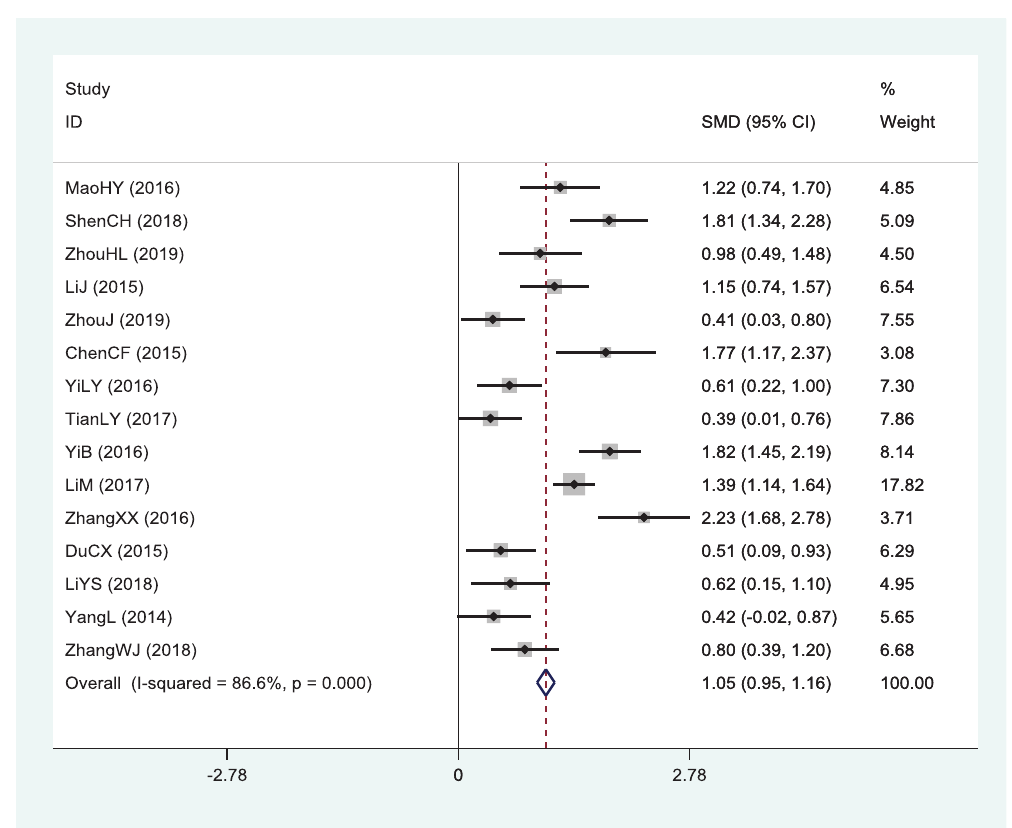
Figure 2. Forest plot of the nursing students’ skill score.